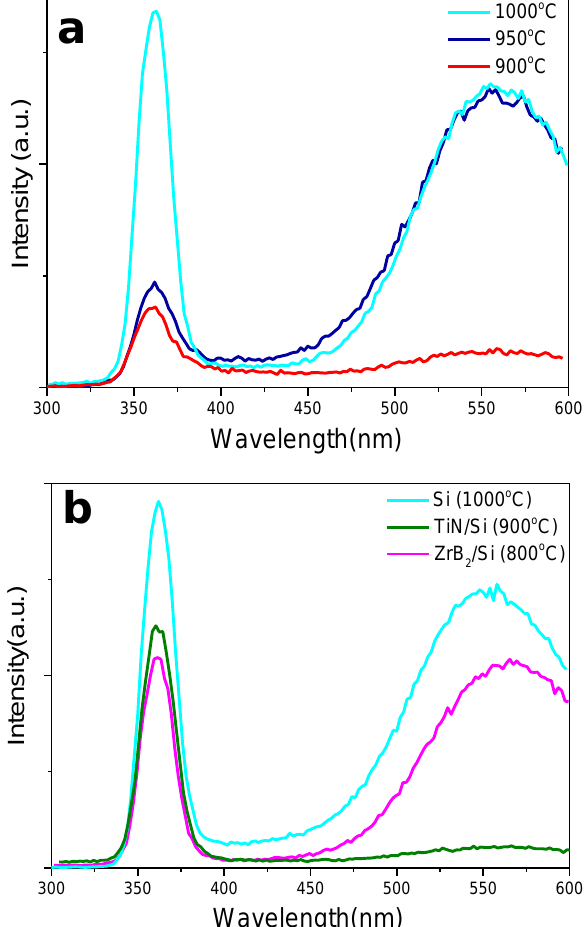
Figure 9. Room-temperature cathodoluminescence spectra of GaN NRs grown ( a ) at different temperature on Si and ( b ) on different templates.